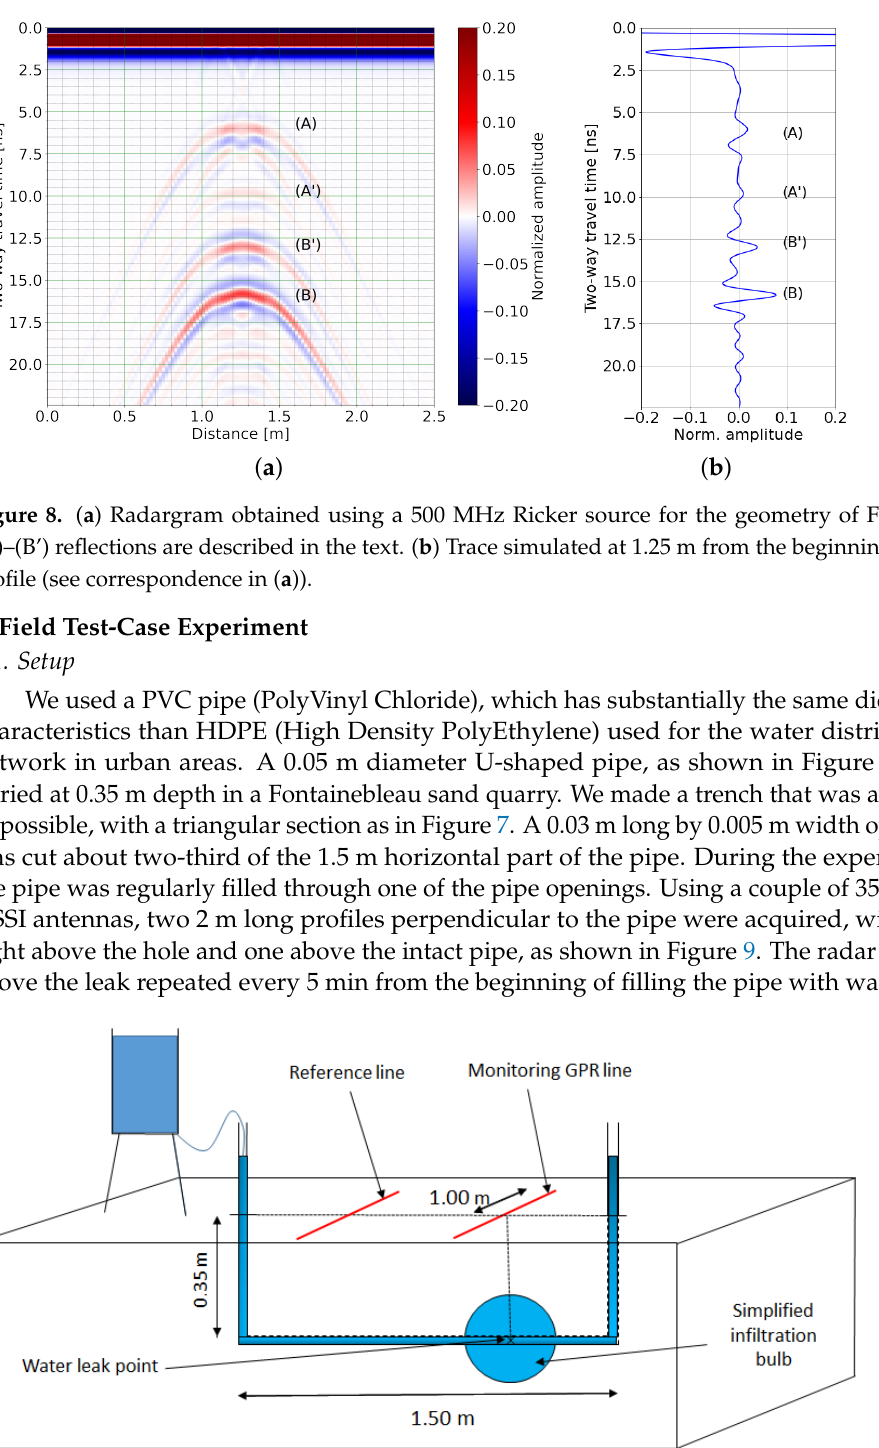
Figure 9. Geometry of the field experiment. The U-shaped pipe is 0.35 m deep and 1.5 m long. GPR profiles were recorded perpendicularly to the pipe’s main direction, right above the